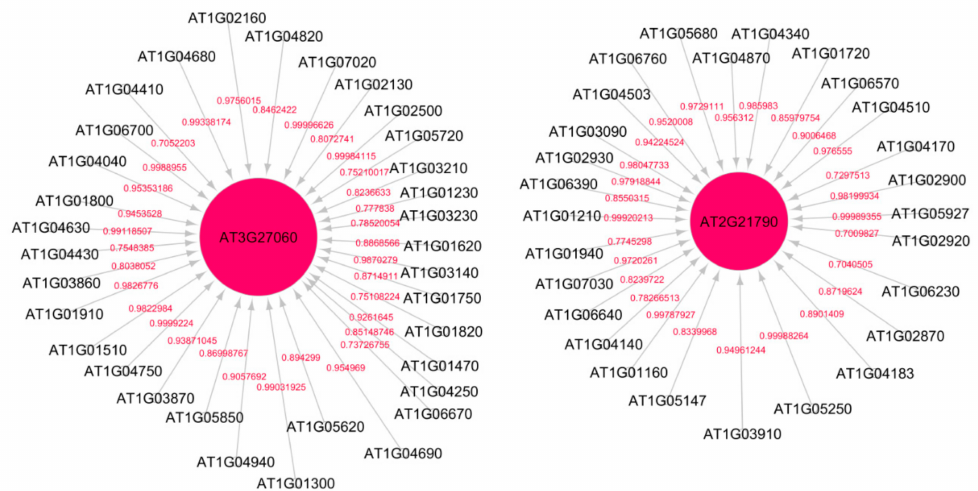
Figure 3. Subnetwork for DNA metabolic process under low radiation dose (LRD4) dataset. Red circles are hub genes. The hub genes AT3G27060 (TS02) and AT2G21790 (RNR1) are being activated by the genes at the non-arrow end of the edge. Both of these genes have a high in-degree